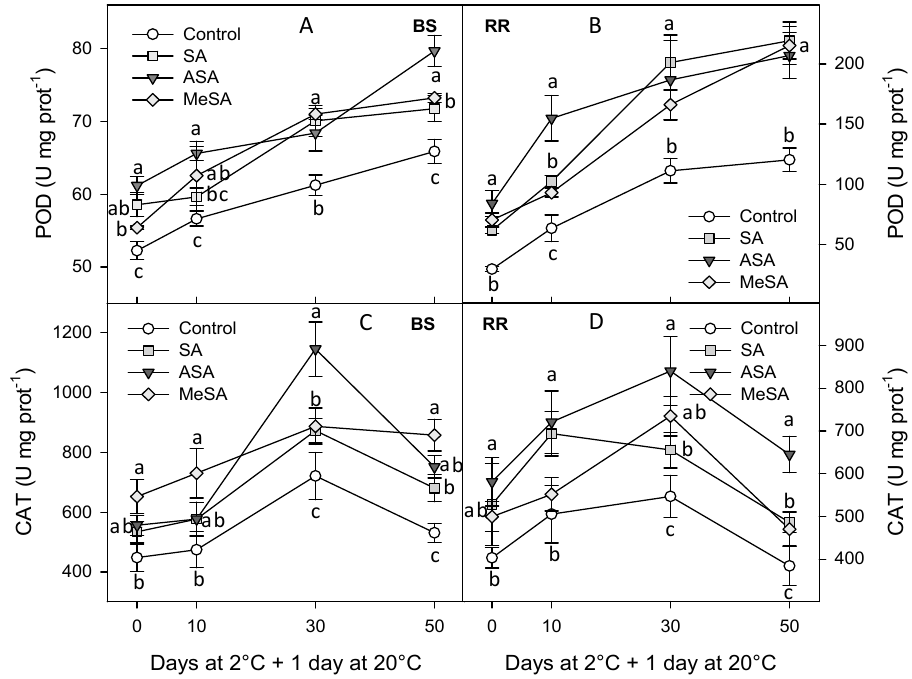
Figure 4. Activity of peroxidase (POD) for “Black Splendor” (BS) ( A ) and “Royal Rosa” ( B ) cultivars and catalase (CAT) for “Black Splendor” (BS) ( C ) and “Royal Rosa” ( D ) plum cultivars from control and salicylic acid (SA)-, acetyl salicylic acid (ASA)-, and methyl salicylic acid (MeSA)-treated trees at harvest and along storage at 2 ° C + 1 day at 20 ° C. Data are the mean ± SE of three replicates. Different lowercase letters show significant differences ( p < 0.05) among treatments for each sampling date and cultivar.